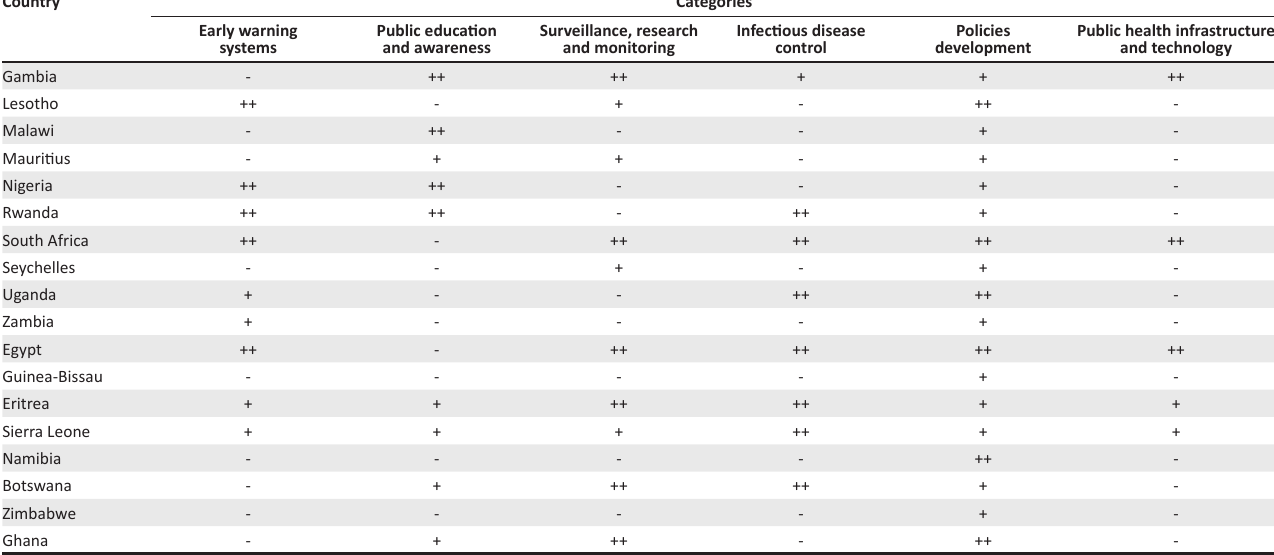
TABLE 3: Summary status regarding the implementation of adaptation measures.